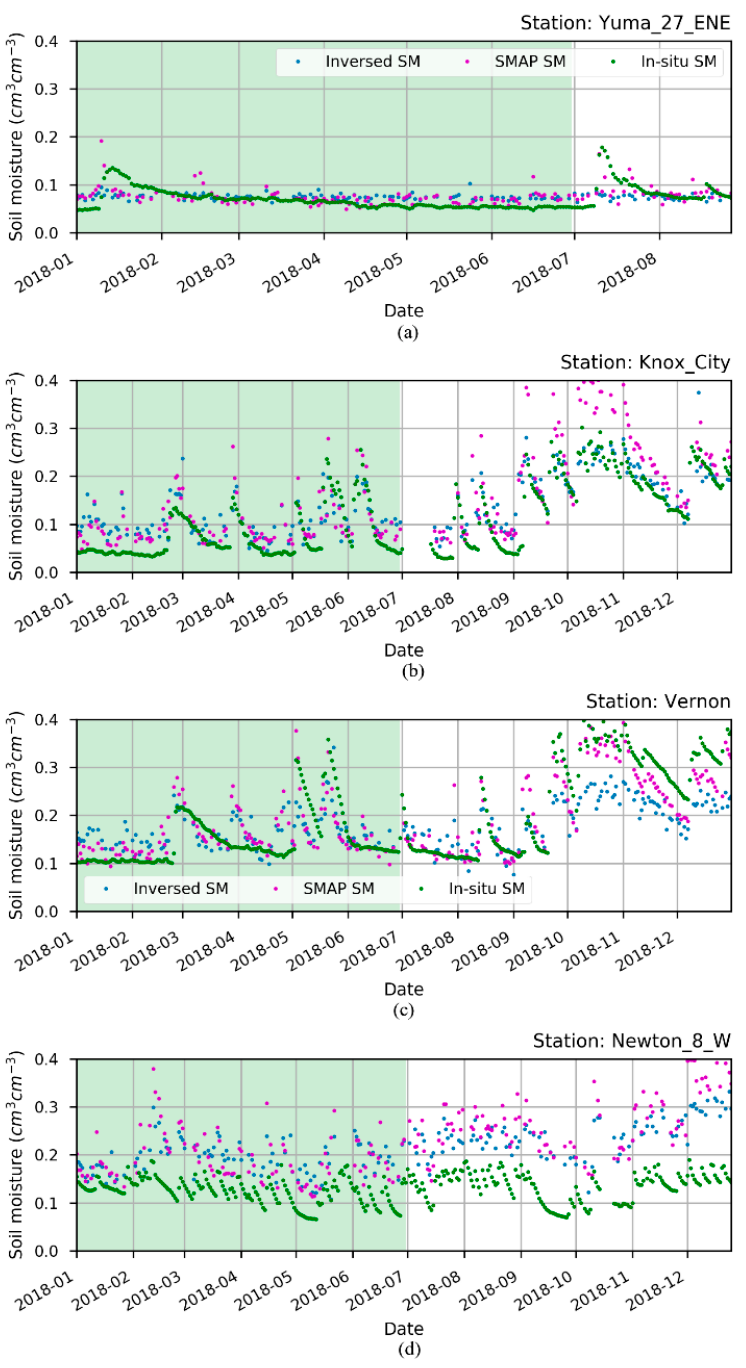
Figure 8. Time series of inversed SSM, SMAP SSM, and in situ SSM comparison at in situ SSM stations Yuma-27-ENE ( a ), Knox City ( b ), Vernon ( c ), and Newton-8-W ( d ).